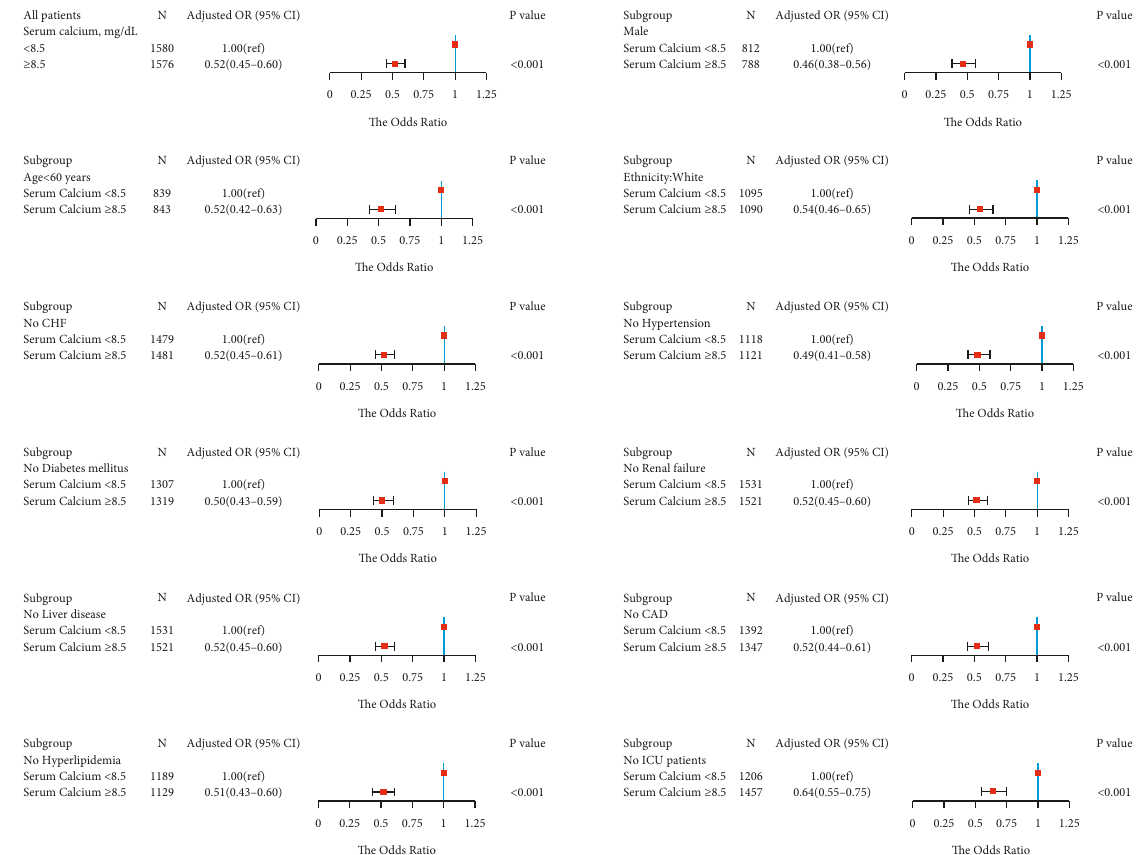
Figure 4: Results of subgroup analyses of the serum calcium level and a hospital length of stay (LOS) > 5 days according to clinical